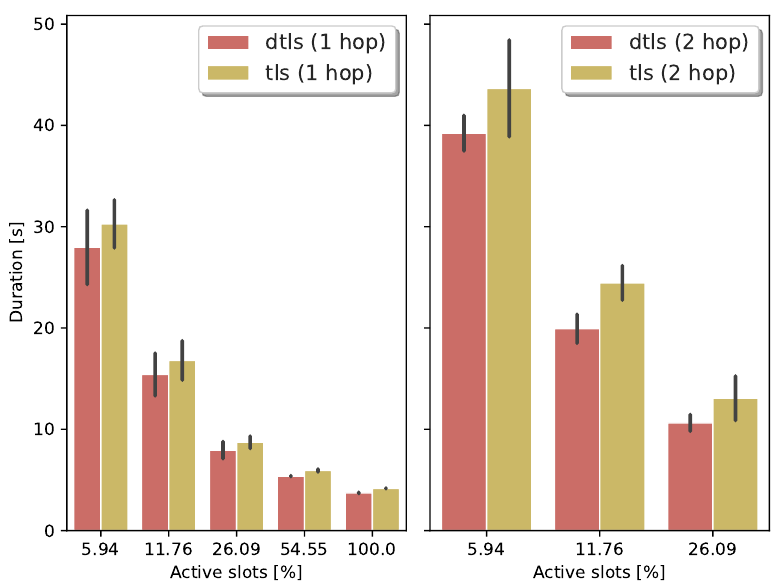
Figure 5. The duration for the (D)TLS handshake increases fast when the TSCH schedule is sparsely